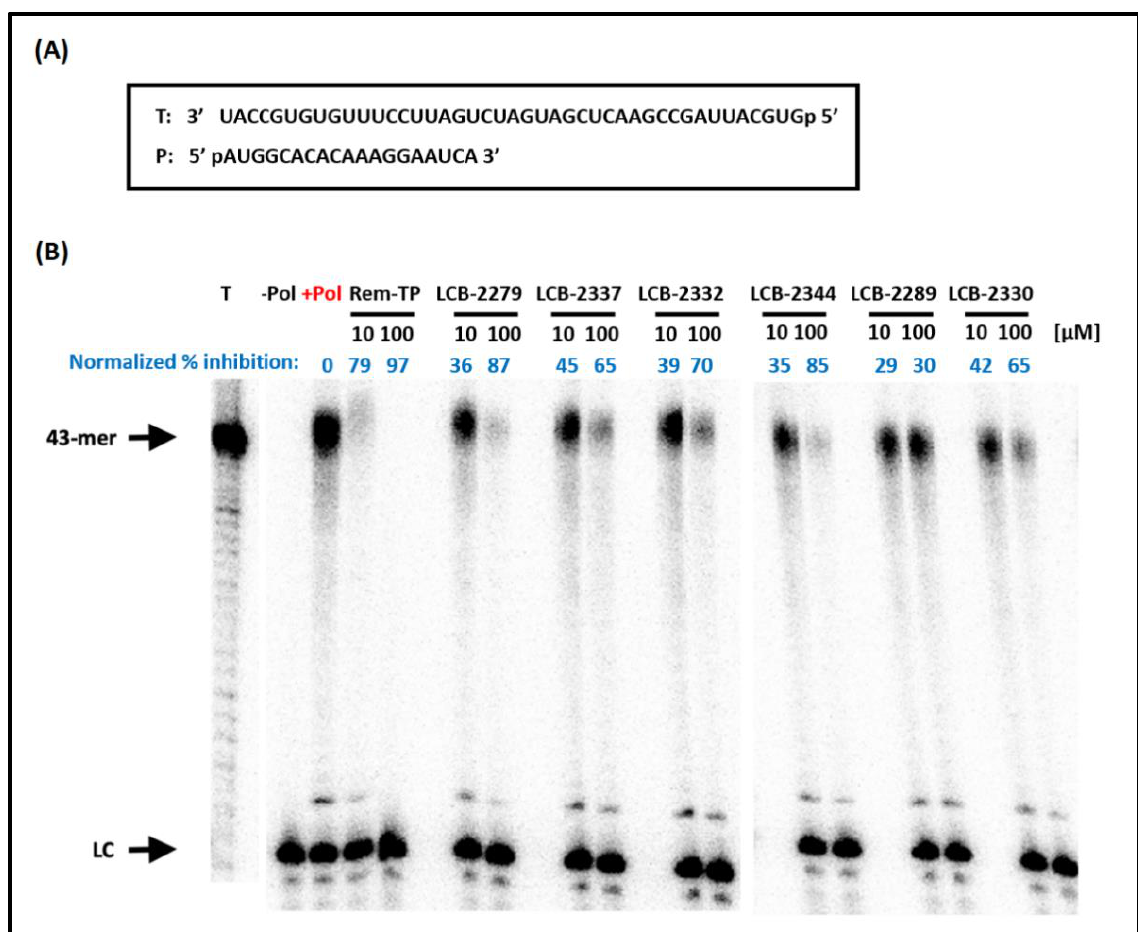
Figure 3. Inhibition of SARS-CoV-2 RdRp activity: ( A ) RNA 19-mer primer/43-mer template used in the SARS-CoV-2 RdRp reactions. ( B ) Full-length 43-mer RNA product syntheses by SARS-CoV-2 RdRp complex (nsp12/nsp7/nsp8) in the presence/absence of respective inhibitors. ( − Pol) is the negative control without SARS-CoV-2 RdRp whereas (+Pol) is the no-treatment control. (T) is the 43-mer RNA template used in the assay. 5′ end 32P-labelled 20-mer DNA oligo served as the loading control (LC) for each reaction. Reduction in full-length 43-mer RNA synthesis by each inhibitor relative to the no-treatment control (+Pol) is presented as % inhibition normalized with the loading control (LC).